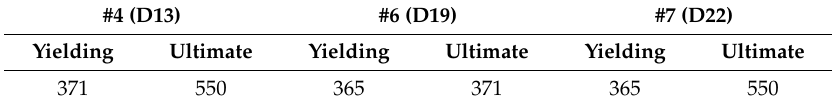
Figure 1. RC frame and the reinforcement arrangement of the post-installed wall of RCW1. Table 1. Yielding and ultimate strengths of the reinforcements of the specimens (unit: MPa).